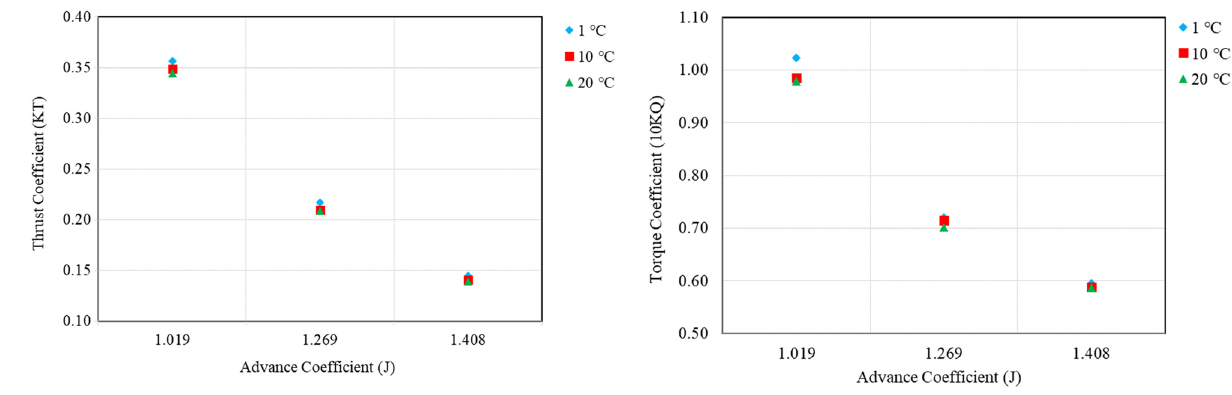
Figure 17: Numerical result of torque coe ffi cient K 10 Q ) ( under var - iation of advance coe ffi cient.